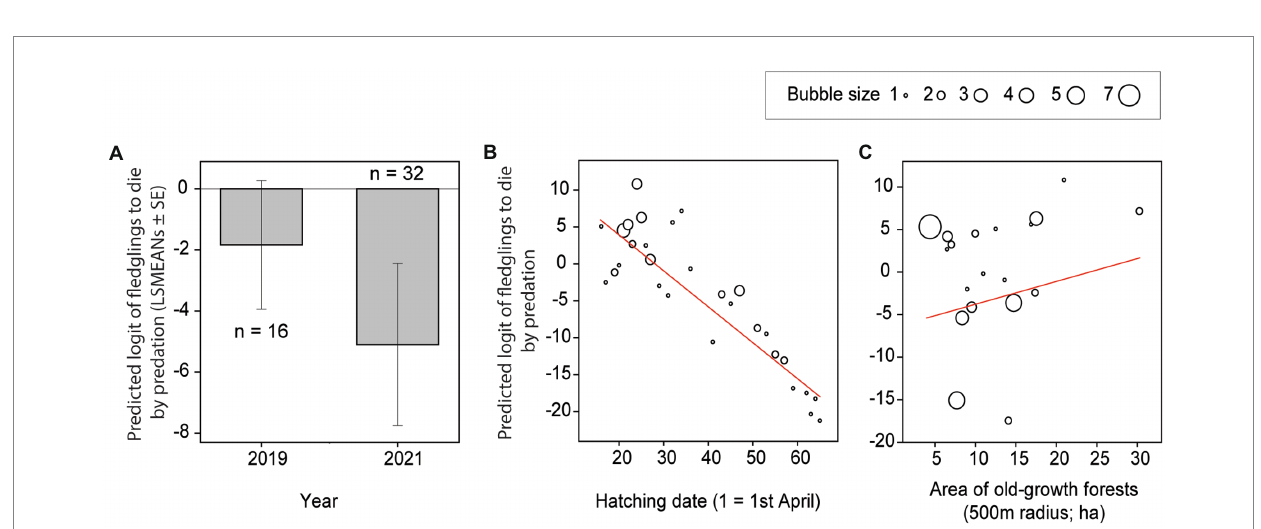
FIGURE 3 Fledglings’ probability of dying by predation. Least square means (A) and bubble graphs (B, C) of predicted logit values of fledglings’ probability of dying by predation of Tengmalm’s owl offspring during two post-fledging dependency periods (2019, 2021) (A ; LSMEANs ± SE ) , and plotted against individual nestlings’ hatching date (B) , and the area of old-growth forests within a 500 m radius from a given nest (C) with regression line (red). The bubble size corresponds to the number of predicted (overlapping) cases between 1 and